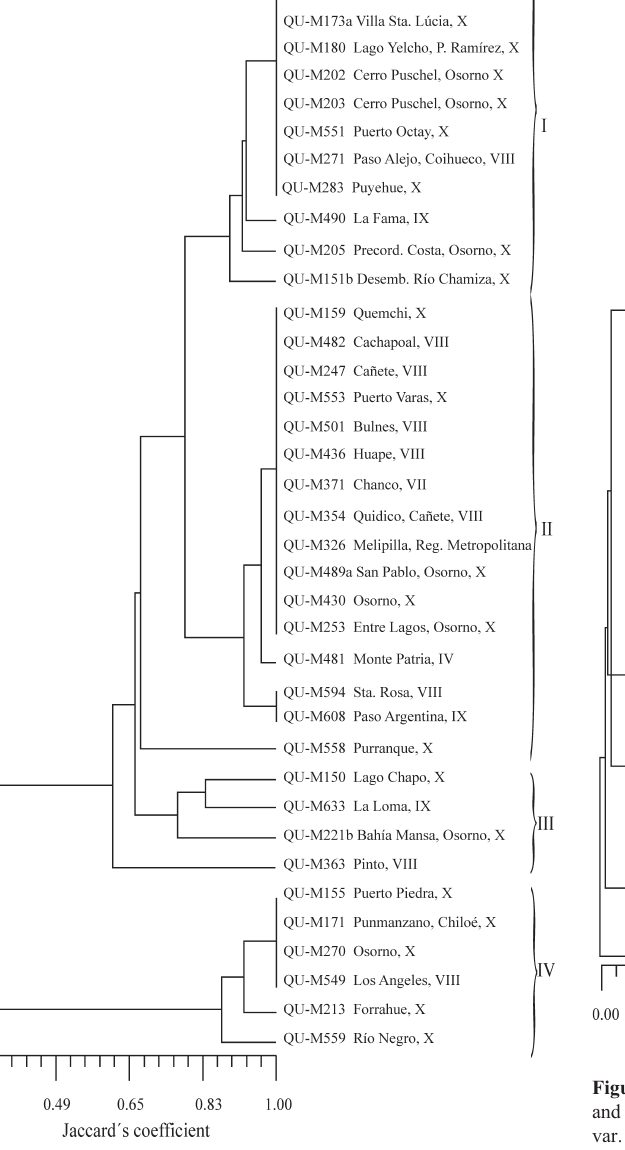
Figure 4 - Dendrogram based on Internal transcribed spacer (ITS) analy- sis of 39 Chilean isolates of Metarhizium anisopliae var.